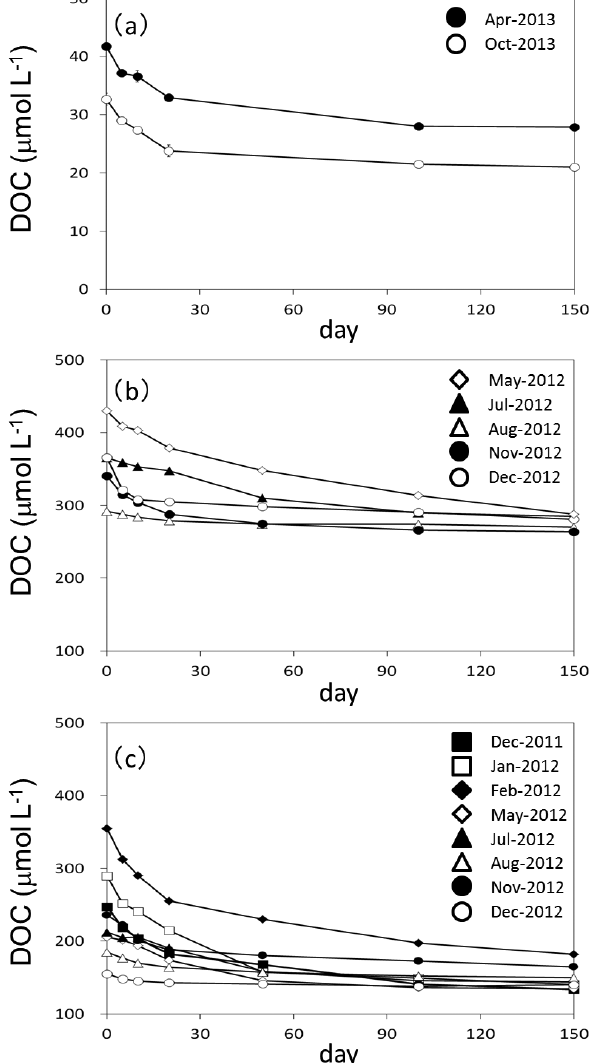
Figure 2. Changes in dissolved organic carbon (µmolL − 1 ) in sur- face water of (a) the upper Arakawa River station, (b) Shibaura STP, and (c) the lower Arakawa River station. Error bars represent the standard